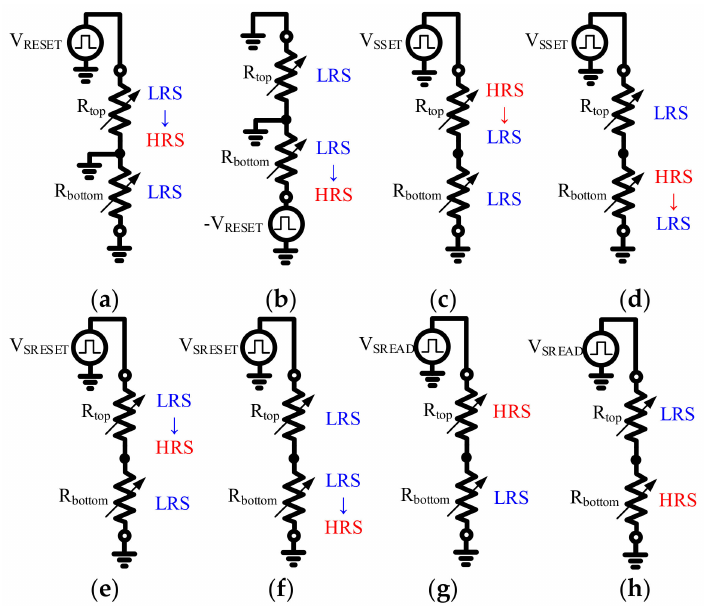
Figure 6. Configuration for the different cell operations: ( a ) write-0; ( b ) write-1; ( c ) masking (‘0’); ( d ) masking (‘1’); ( e ) unmasking (‘0’); ( f ) unmasking (‘1’); ( g ) serial read (‘0’); ( h ) serial read